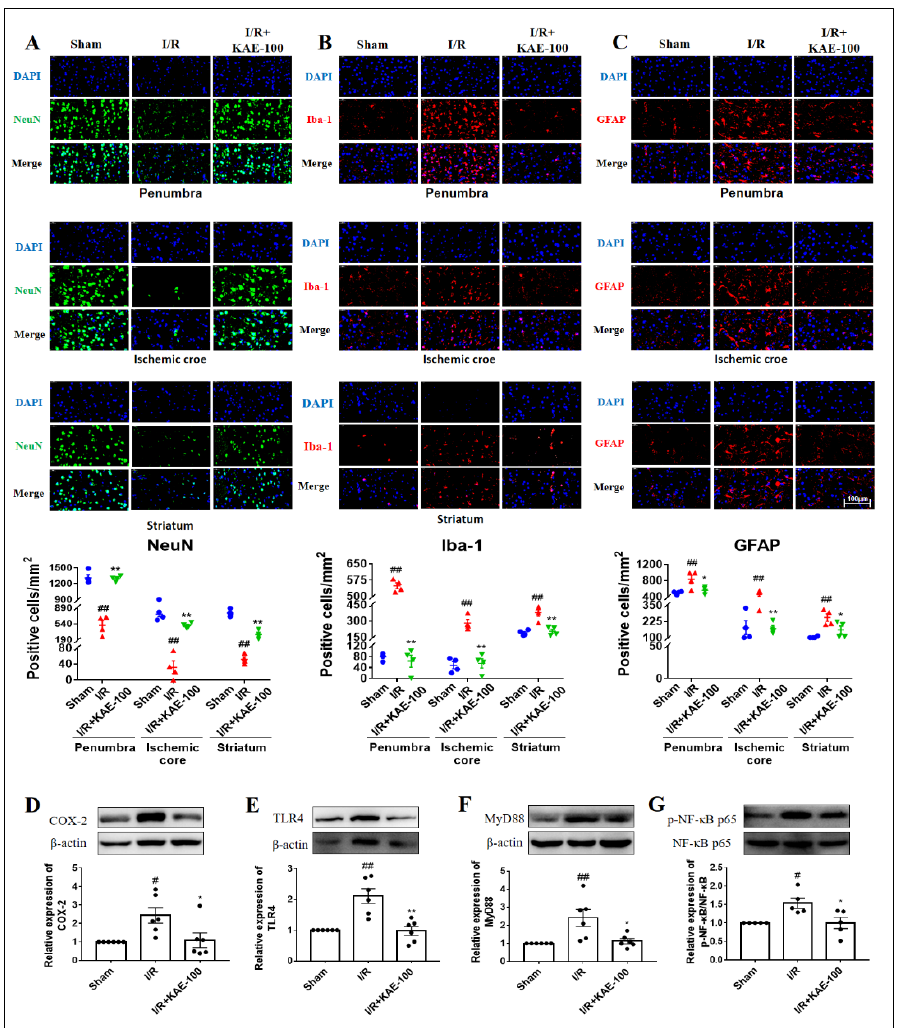
Figure 4. Effect of kaempferol on neuron loss and glial activation on day 3 after cerebral I/R. Repre- sentative fluorescent micrographs of ( A ) NeuN, ( B ) Iba-1 and ( C ) GFAP in penumbra, ischemic core and striatum and quantitative analysis of immunofluorescent staining ( n = 4). 630× magnification, s cale bar = 100 μm. The expression levels of ( D ) COX-2, ( E ) TLR4, ( F ) MyD88 and ( G ) p-NF- κB p65 were assessed by Western blot. Values are expressed as mean ± SEM ( n = 5 – 6) # p < 0.05, ## p < 0.01 vs. Sham group; * p < 0.05, ** p < 0.01 vs. I/R group. KAE: kaempferol.